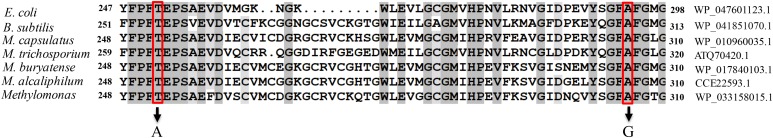
Sequence alignment of PheS. The PheS C-terminal region of strains Escherichia coli K12, Bacillus subtilis 168, M. capsulatus (Bath), M. trichosporium OB3b, M. buryatense 5GB1C, M. alcaliphilum 20Z, and Methylomonas sp. LW13 were aligned using ClustalW2. The residues boxed with a red line indicates the conserved alanine residue that can be subjected to mutagenesis to create p-Cl-Phe sensitivity.